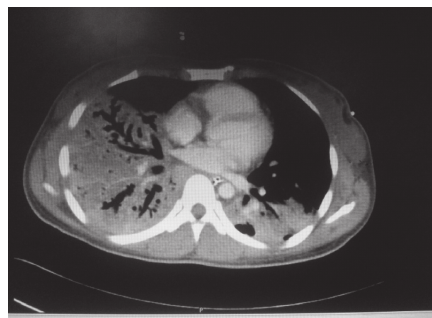
Figure 2: Computed tomography of the lung demonstrated col- lapse consolidation of the right middle and lower lobe along with the lower lobe with associated dilated segmental bronchioles. Diffuse patch ground-glass opacity seen in both lung fields, but worst in the left